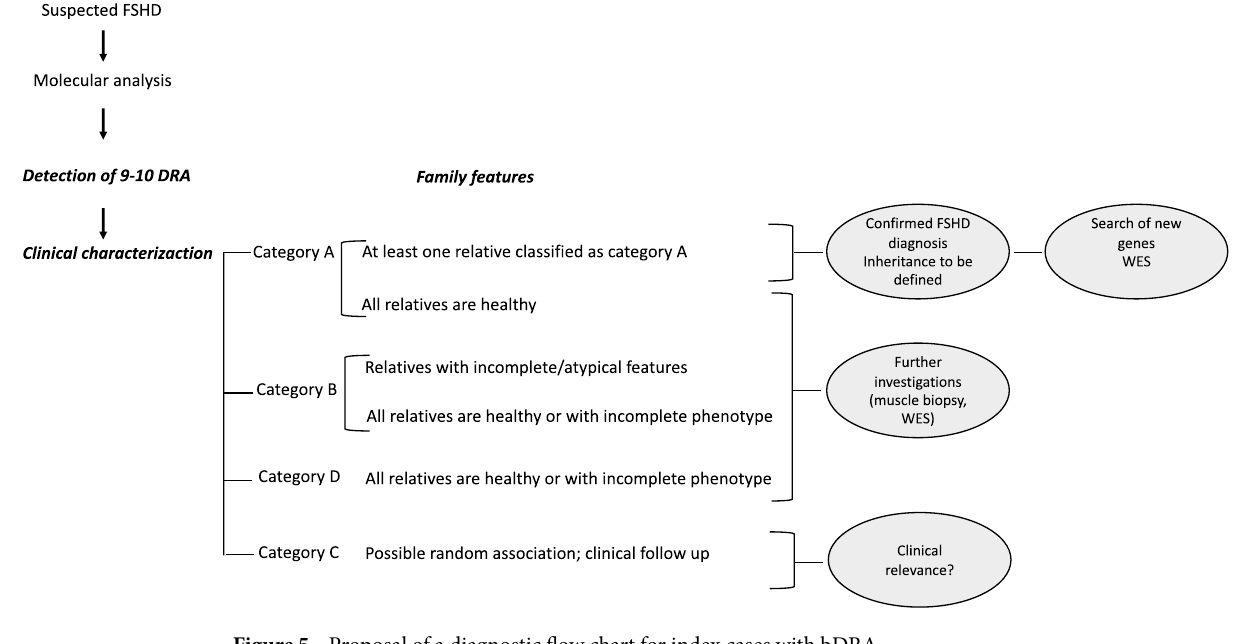
Figure 5. Proposal of a diagnostic flow chart for index cases with